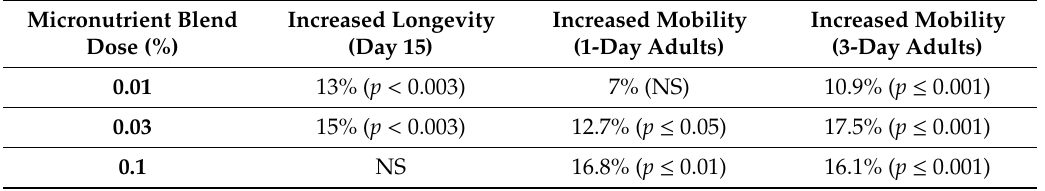
Table 4. Summary of the functional activity provided by the micronutrient supplement to C. elegans